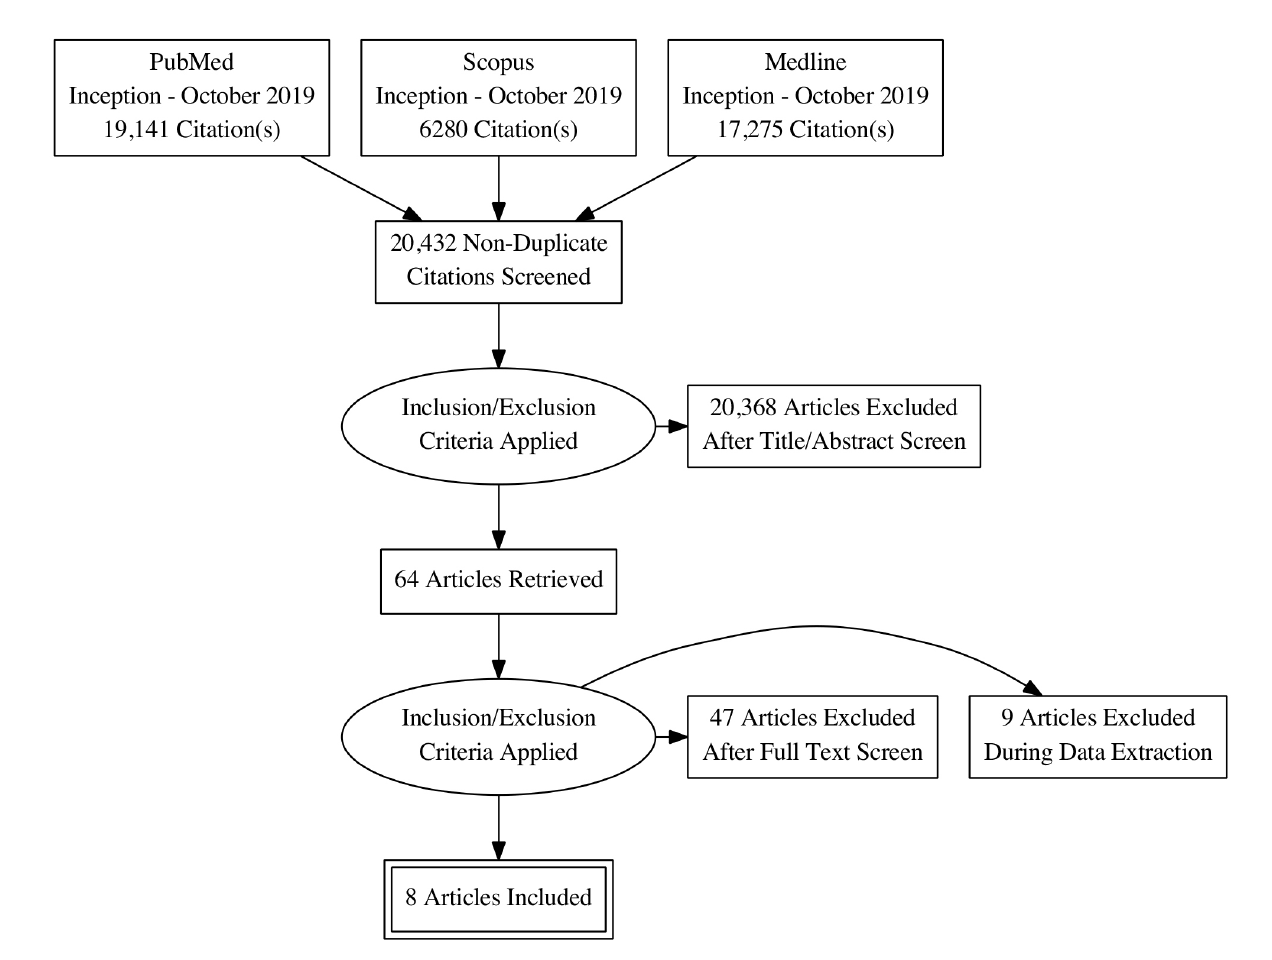
Fig. 1 - Preferred reporting items for systematic reviews (PRISMA) diagram.